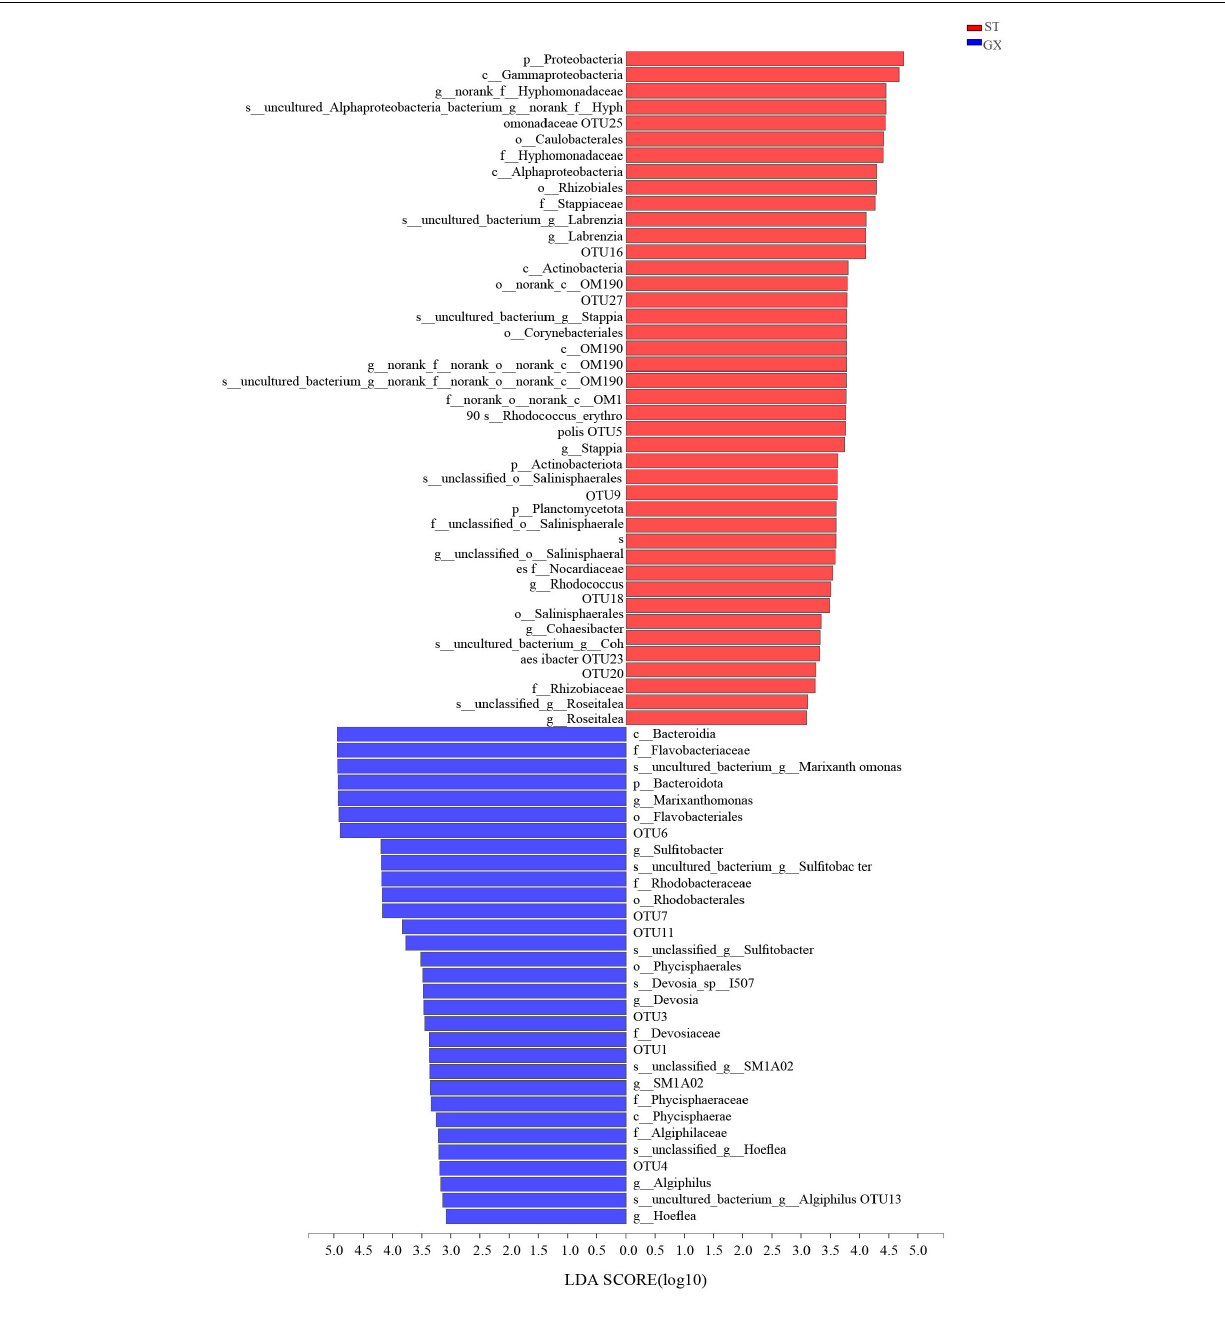
FIGURE 4 | Indicator bacterial taxa with LDA scores > 2. Different-colored regions of the bars in panel indicate taxa from different co-cultures. GX, P . globosa GX strain co-culture; ST, P . globosa ST strain co-culture. p, phylum; o, order; f, family; g, genus; s,